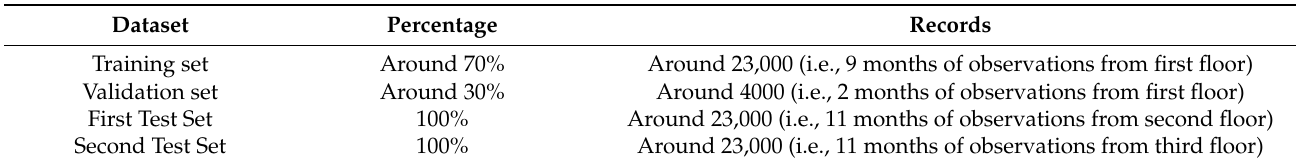
Table 2. Database split recap for generalised model.